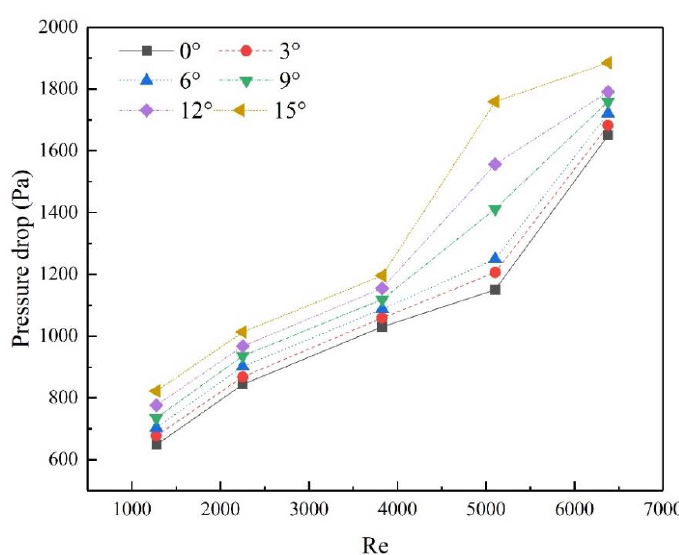
Figure 14. Pressure drops of different taper angle models.